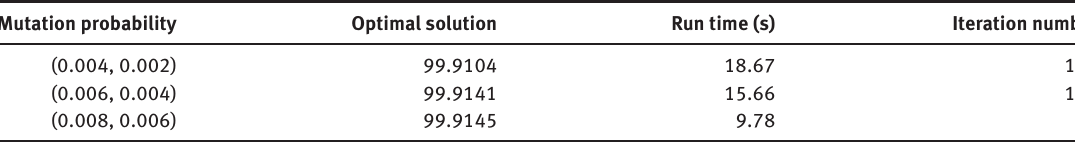
Table 5. Comparison of Running Results of Different Mutation